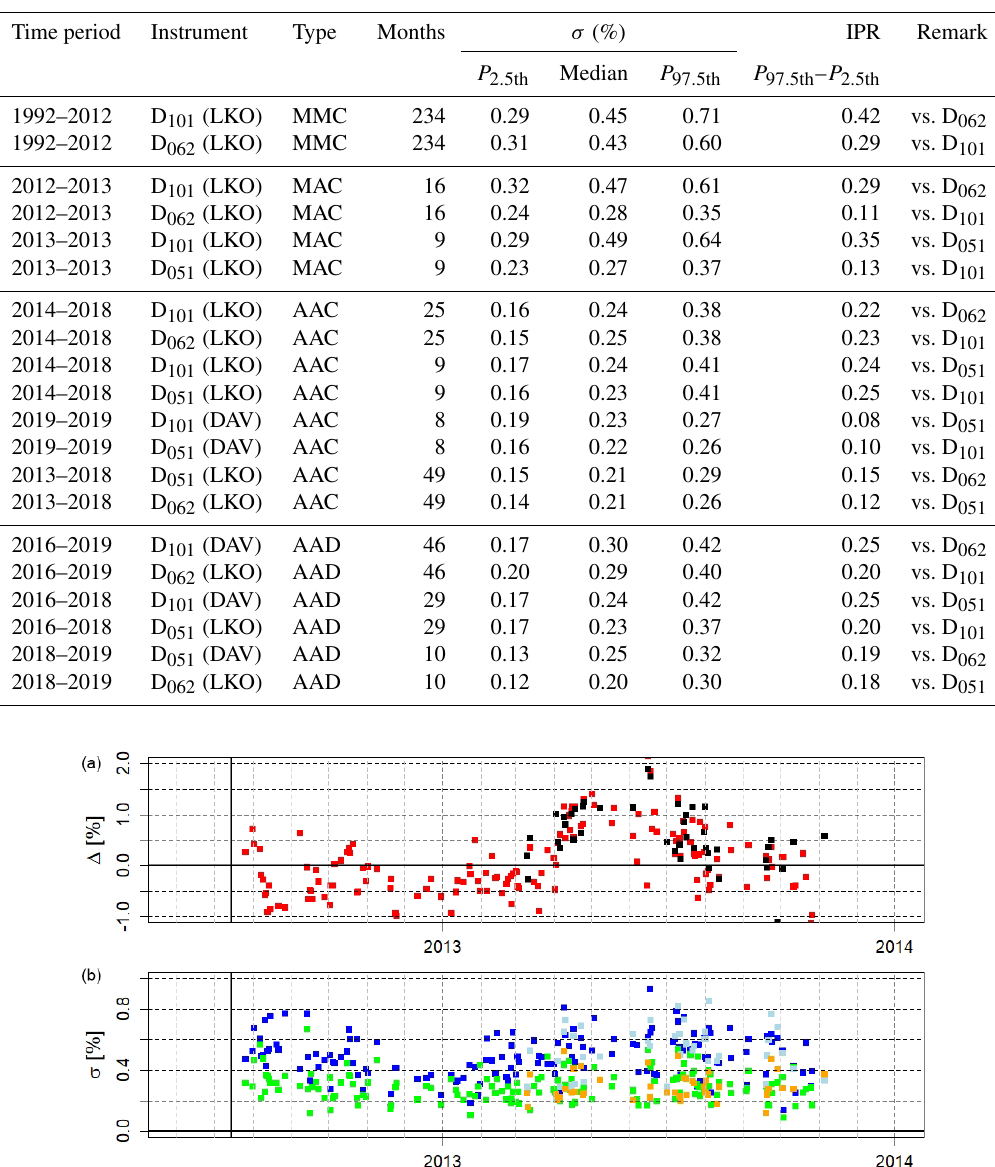
Table 4. Mean monthly median of the parameters σ i for the four subperiods. Time period Instrument